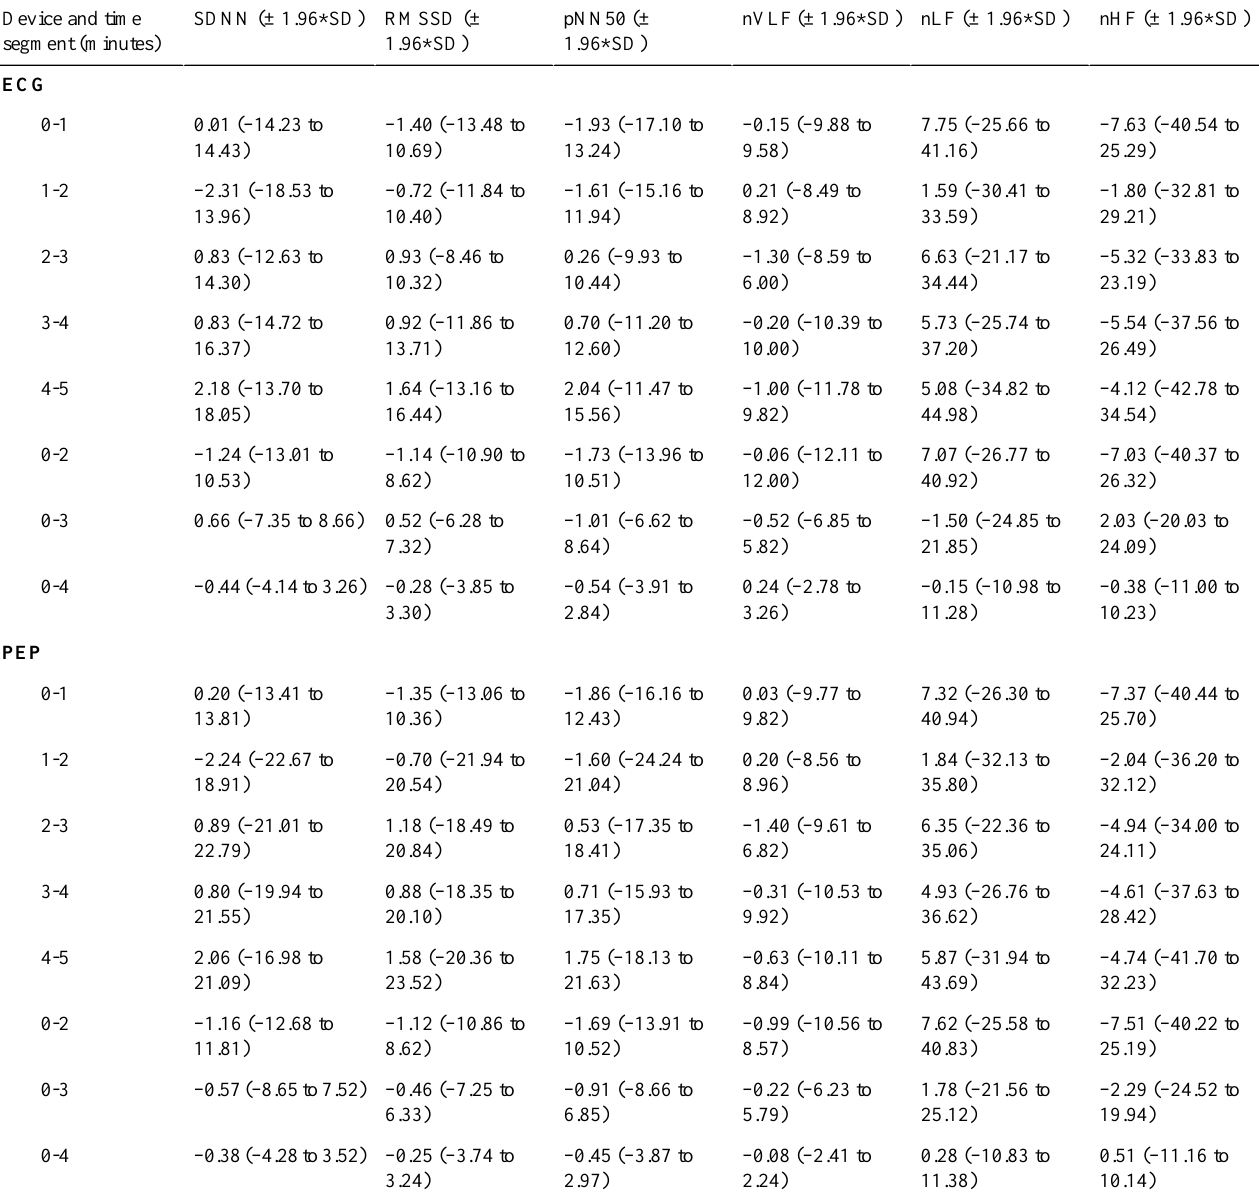
Table 3. Limits of agreement (± 1.96*SD) of time-domain and frequency-domain heart rate variability parameters in different time segments of the electrocardiogram and Pulse Express PRO measurements compared with the 0-5–minute standard a